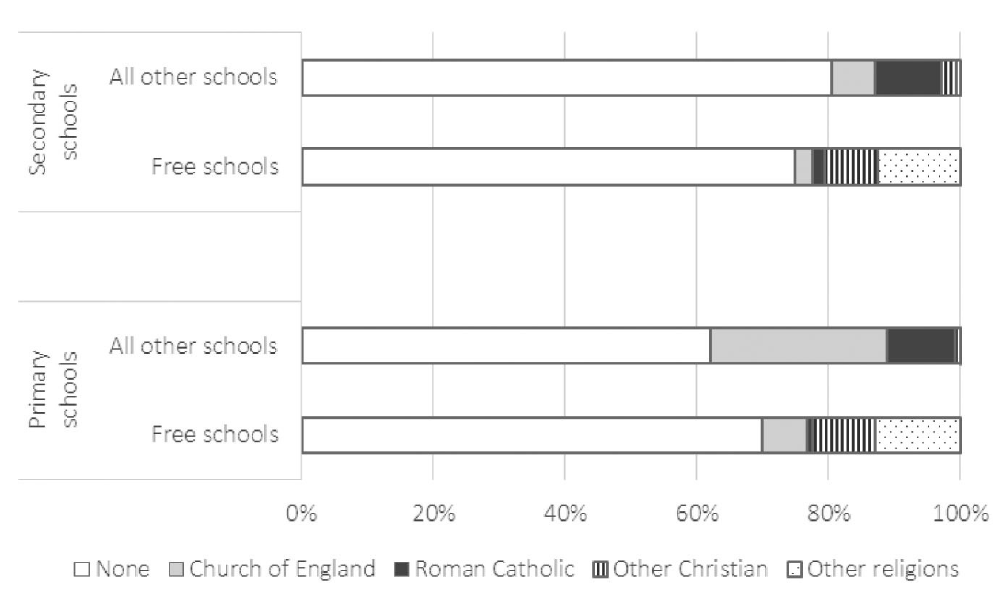
Figure 1: Religious denomination of free schools